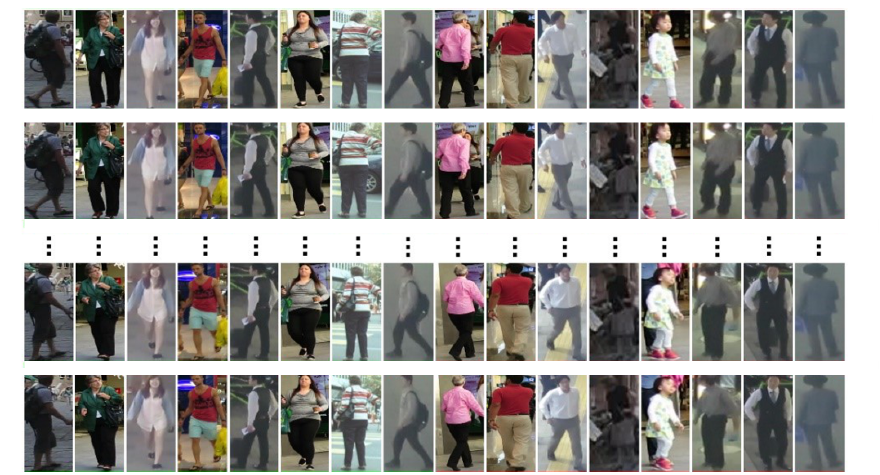
Figure 5. Examples of individuals detections throughout sequences of the MOT17